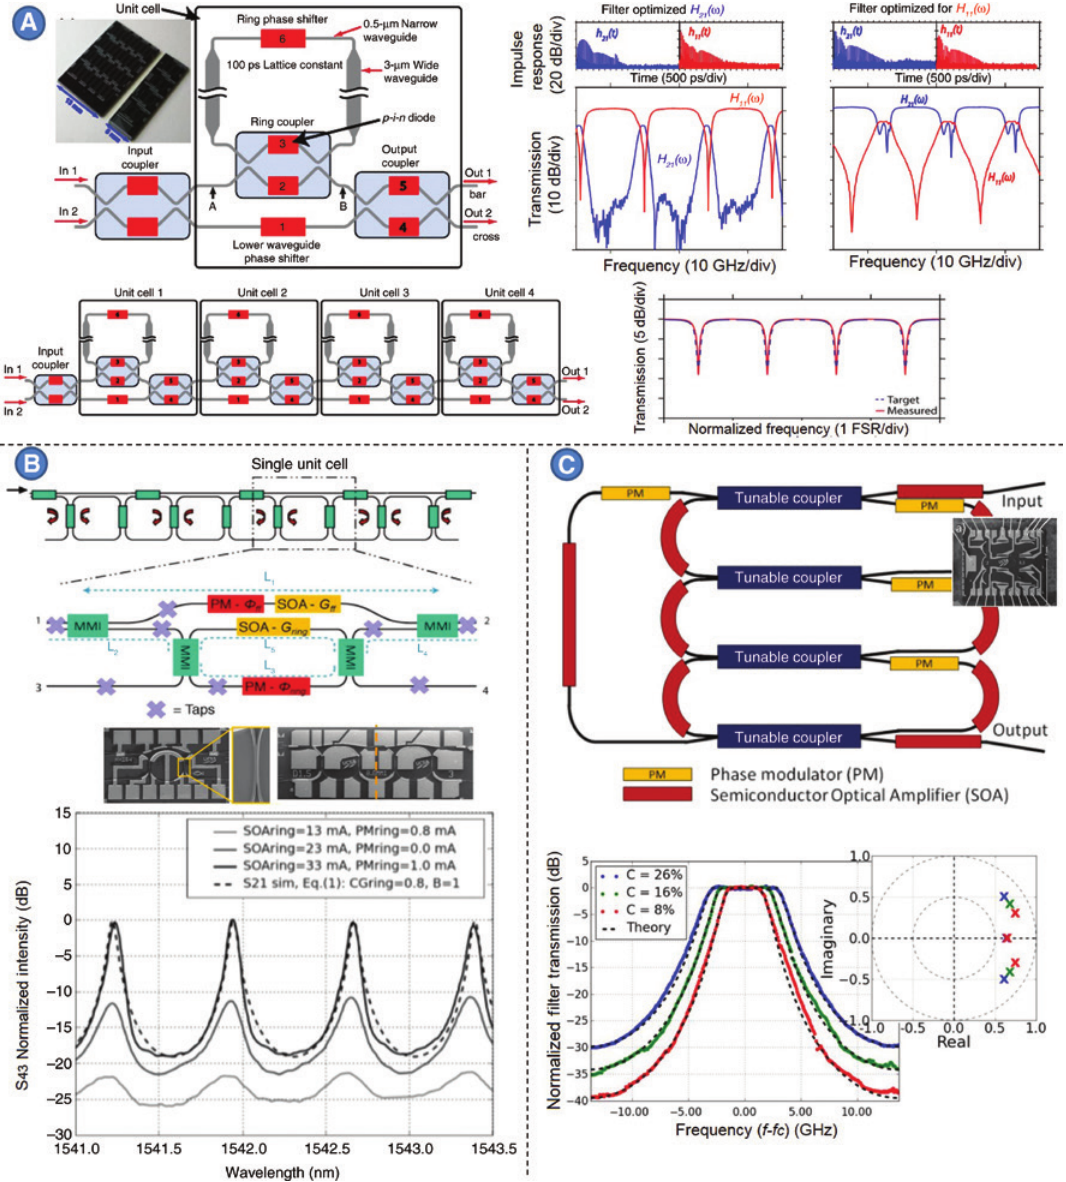
Figure 24: (A) A design of lattice filter in silicon (Figure 12) [102] (Copyright in 2014, IEEE). (B) A design of lattice filter in InGasAsP-InP [103] (Copyright in 2010, IEEE). (C) A design of a bandpass filter with zero insertion loss [104] (Copyright in 2011, Optical Society of America,